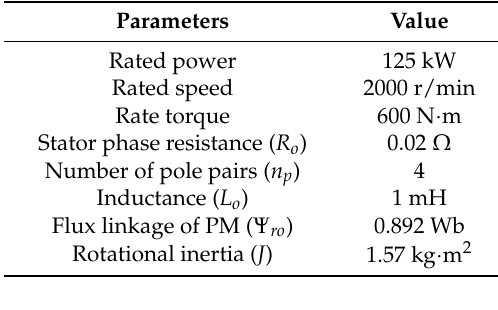
Table 1. Main parameters of surface permanent magnet synchronous motor (SPMSM).